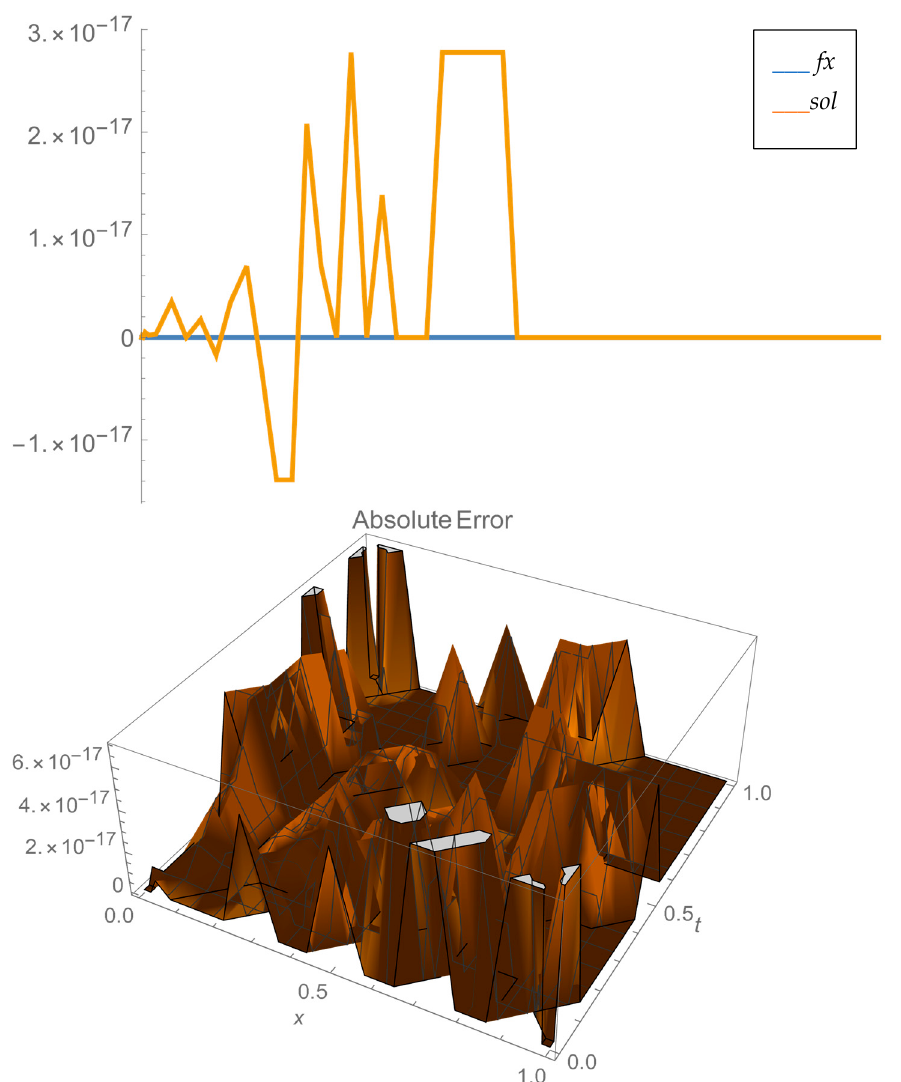
Figure 1. The illustrations of the contrast between exact (sol) and approximate ( fx ) solutions are presented on the left-hand for t = x replaced in the solutions of Equation (10). This shows complete overlap of the solutions. On the right-hand side, a 3D plot of the absolute error between exact and estimated solutions is also shown in the intervals 𝑥 ∈ [0,1] and 𝑡 ∈ [0,1] . The graph shows the accuracy of the numerical results is of the order of 10 − 17 . This kind of accuracy occurred with an only n = 1-degree polynomial basis